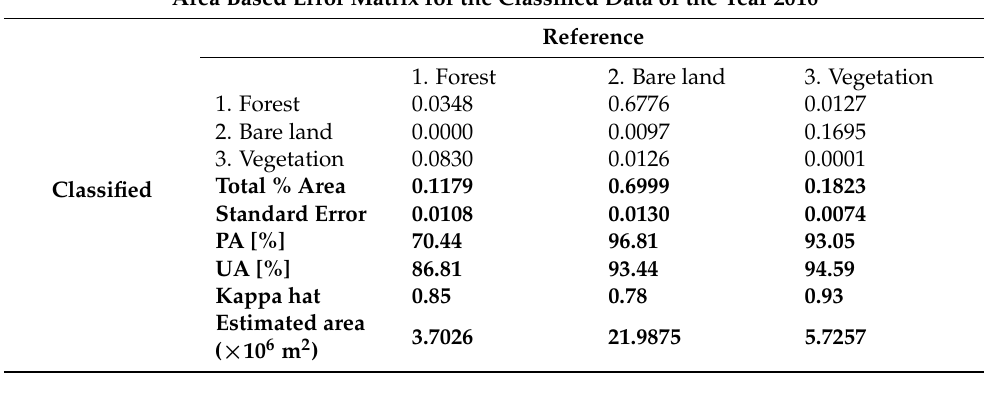
Area Based Error Matrix for the Classified Data of the Year 2016